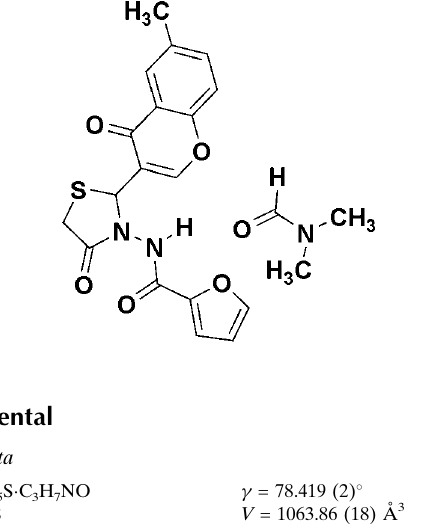
4-oxothiazolidin-3-yl group which is